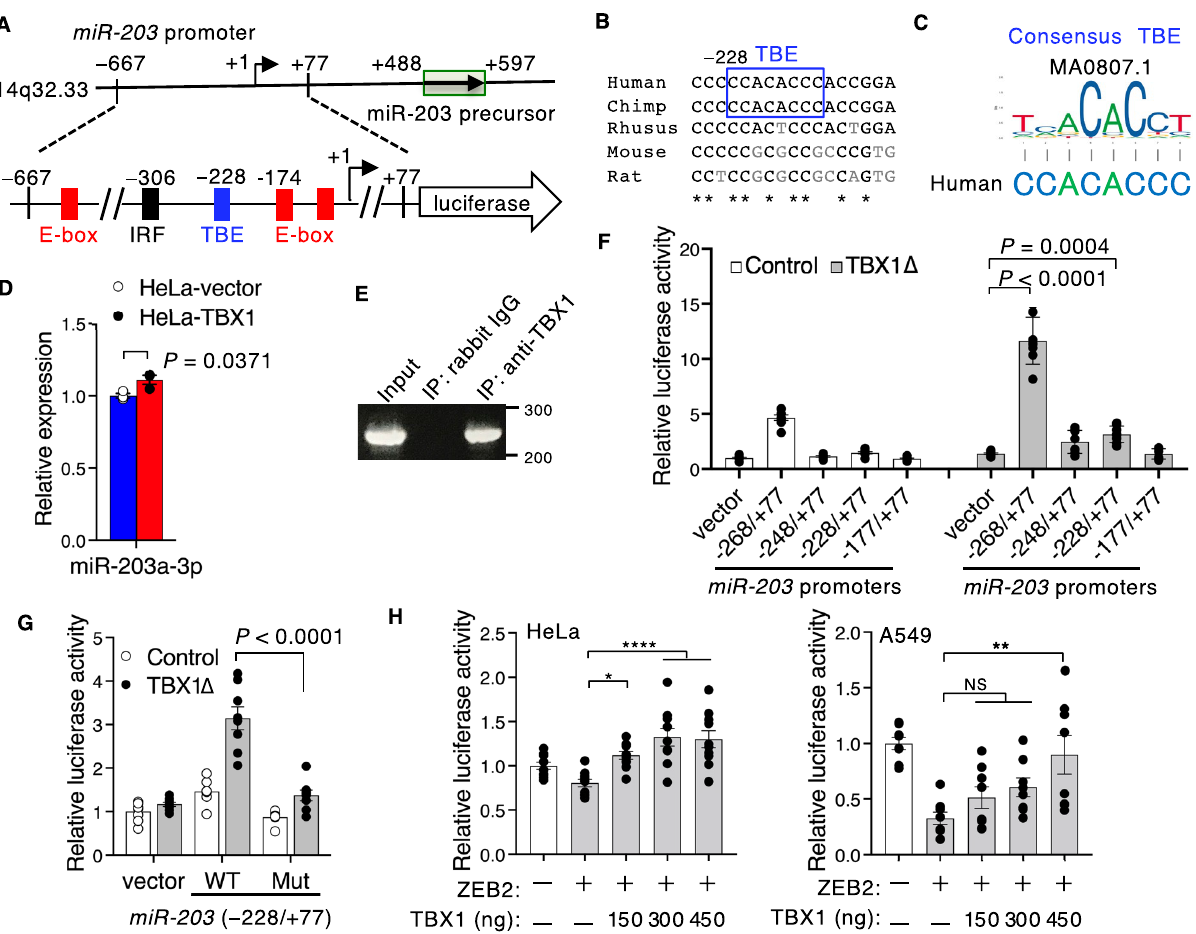
predicted TBE (blue box), as well as ZEB1-binding E-boxes (red boxes) 24 and an IRF1-binding site (black box) 50 . ( B ) Nucleotide conservation of the miR-203 promoter, including TBE. Asterisks indicate